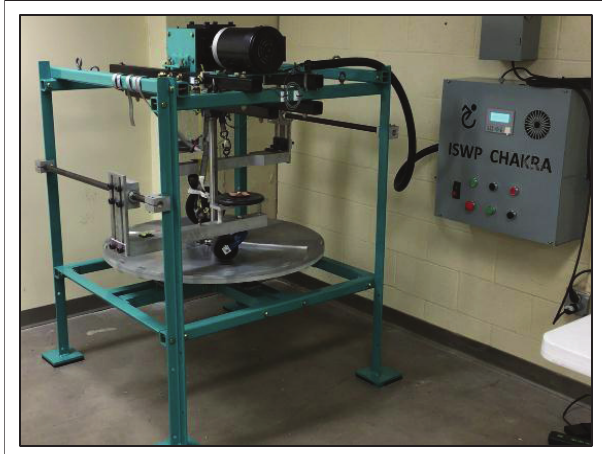
FIGURE 12: ISWP Caster Assembly Test.